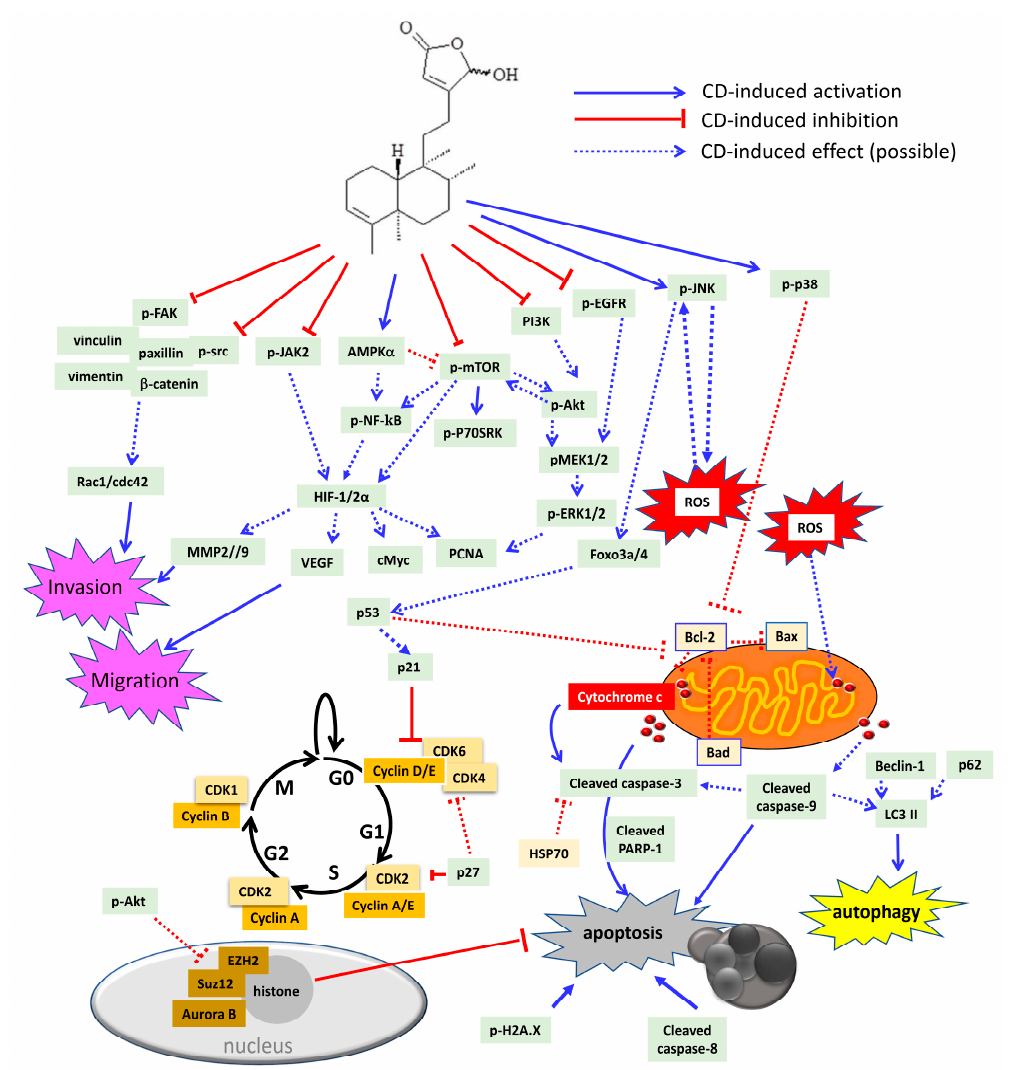
Figure 5. Schematic diagram of CD-induced possible molecular mechanisms in different tumor cells. CD could block cell proliferation through inactivation of several oncogenic molecules, including dephosphorylation of epidermal growth factor receptor (EGFR), PI3K, Akt, mammalian target of rapamycin (mTOR), ribosomal protein S6 kinase beta 1 (P70S6K), mitogen-activated protein kinase kinase 1/2 (MEK1/2), extracellular signal regulated kinase 1/2 (ERK1/2), and src. Besides, CD could also arrest cell cycle either at G0/G1 or G2/M phase through inhibition of cyclins and cyclin-dependent kinases (CDKs), as well as induction of the CDK inhibitor, p21, p27, and p53, respectively. In addition, CD could increase sub-G1 population, which indicates DNA fragmentation related to cell apoptosis. CD can trigger cell death via autophagy and/or apoptosis. CD has been shown to be involved with H2A.X phosphorylation as well as cleavage of caspase-3, -8, -9, and poly (ADP-ribose) polymerase-1 (PARP-1) to induce intrinsic and extrinsic apoptosis. Moreover, CD could promote ROS overproduction, which may induce cytochrome c release from the mitochondria outer membrane. The anti-apoptotic pro- teins that CD could suppress are heat shock protein 70 (HSP70) and B cell lymphoma 2 (Bcl-2). The pro-apoptotic proteins that CD could stimulate are Bad and Bax. Accordingly, CD induces phosphorylation of C-Jun N-terminal kinase (JNK),